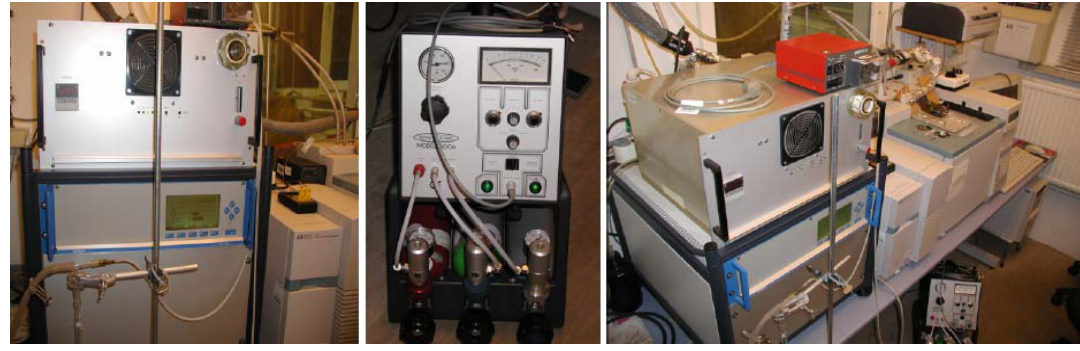
Figure 6. The systems for measurements of gas components in flue gas and for gas analyzes at the Chair of Environmental Technology, University of Rostock, Germany